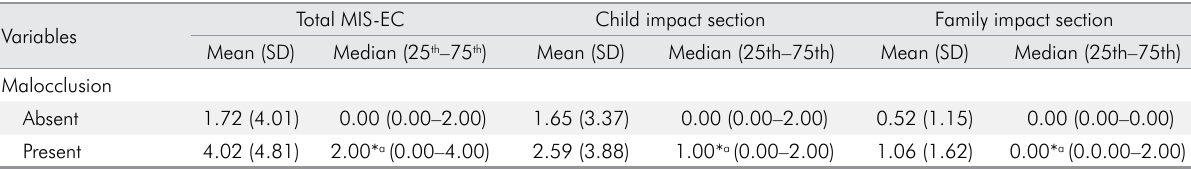
Table 4. Discriminant validity of